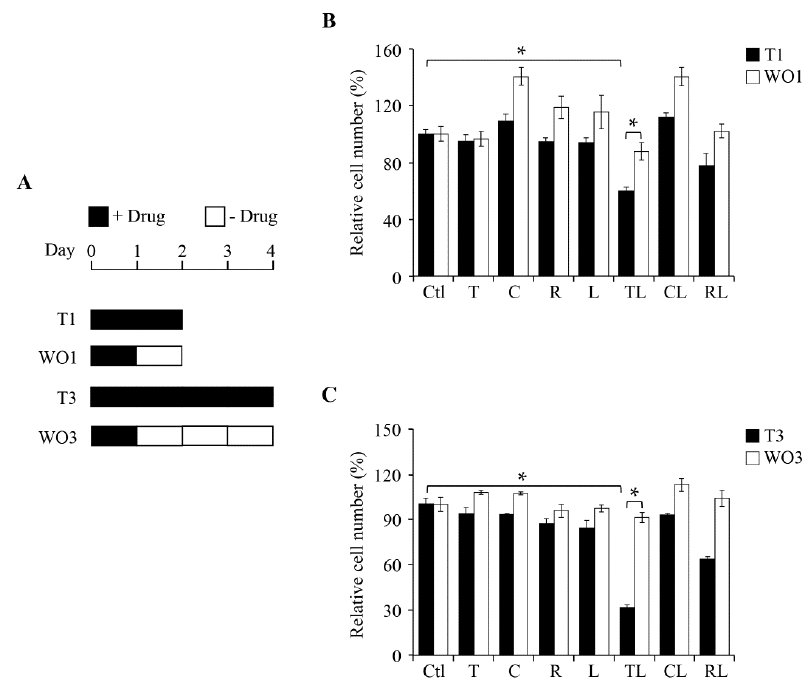
Figure 2. Reversible feature of the anti ‐ proliferation effect following drug ‐ removal. ( A ) The experimental procedures for treatment and drug ‐ removal. Cells were treated with the indicated drugs for 1 day, followed by washout with fresh medium and incubation for an additional 1 (WO1) or 3 (WO3) day(s). ( B , C ) Proliferation assay in cells with or without drug ‐ removal for 1 day ( B ) or 3 days ( C ). The drug concentration used is the same as that in Figure 1D. The relative cell number was estimated by MTT assay. Values represent the means ± S.E.M. ( n = 3). * p < 0.05. C: ciglitazone; CL: combination of ciglitazone and lovastatin; Ctl: control; L: lovastatin; R: rosiglitazone;